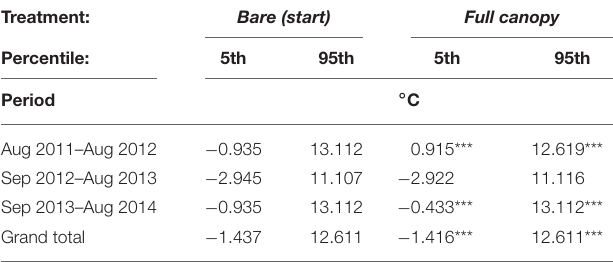
TABLE 5 | 5th (extreme low) and 95th (extreme high) percentiles of yearly temperatures ( ◦ C) in treatment “Full canopy” and “Bare (start)” in inner Kobbefjord mid intertidal from August 2011 to August